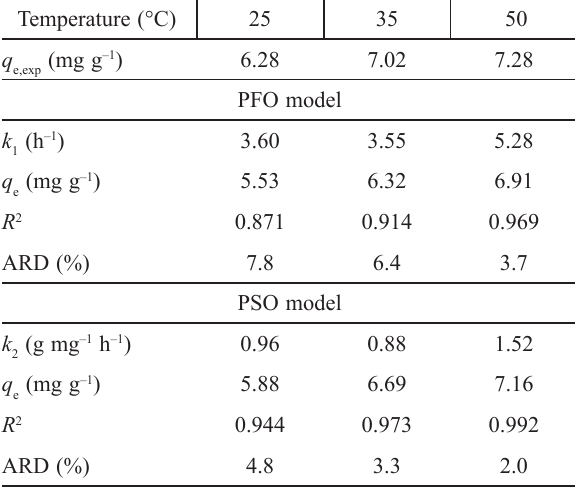
at various adsorption temperatures 2